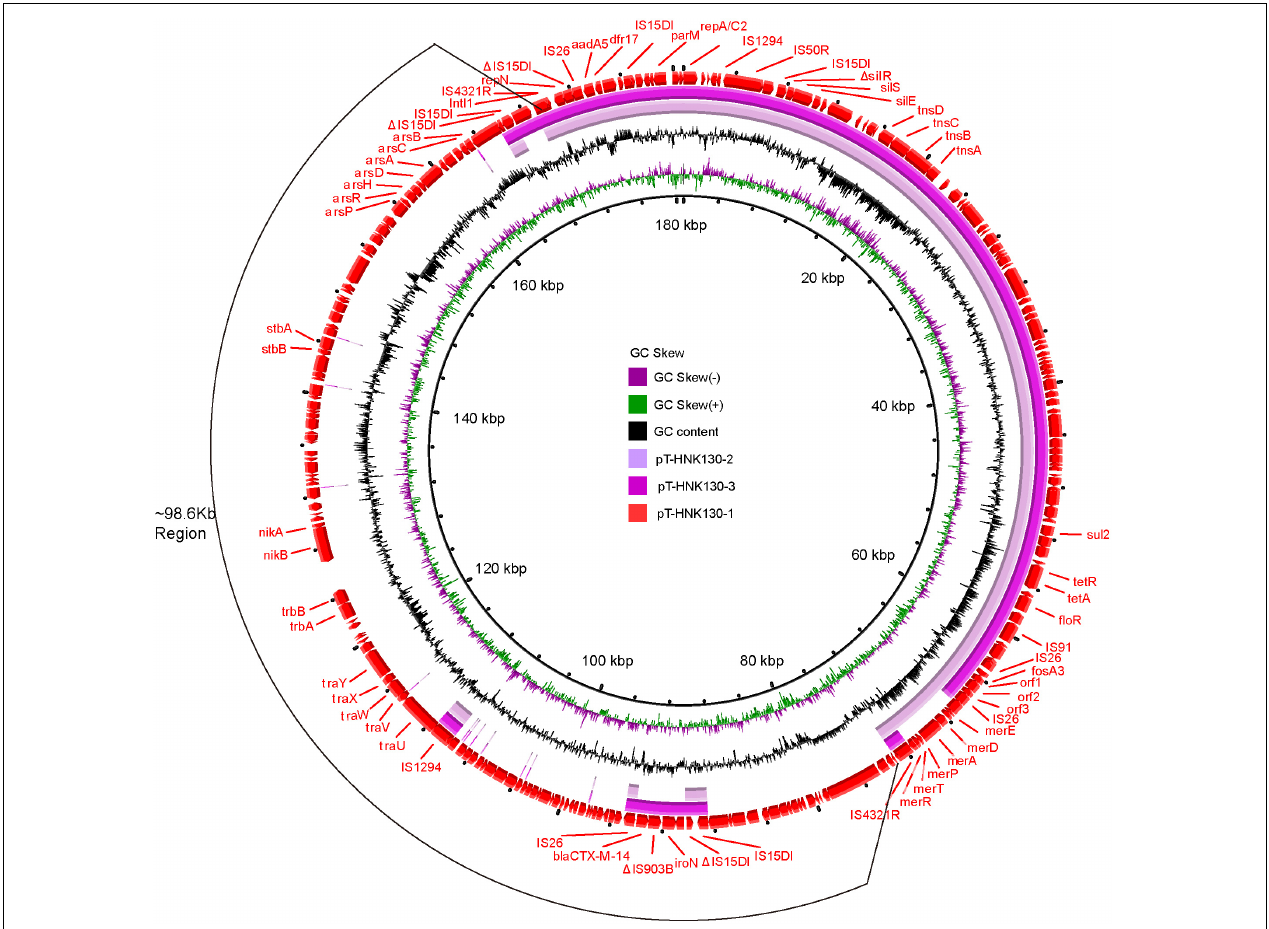
FIGURE 3 | Circular alignment of plasmids pT-HNK130-1, pT-HNK130-2, and pT-HNK130-3. GC content and GC skew are indicated from the inside out. ORFs are indicated by arrows, positions and transcriptional directions of genes depicted in the outer circle belong to pT-HNK130-1, which was included as reference.